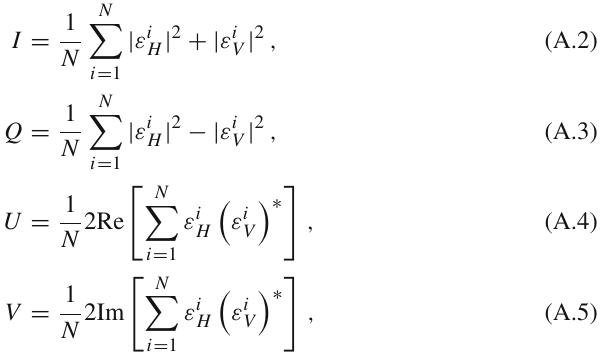
ization angle [5] (bottom panels) and our corresponding estimation for the degree of polarization (top panels) are shown in gray. All angles are measured with respect to the